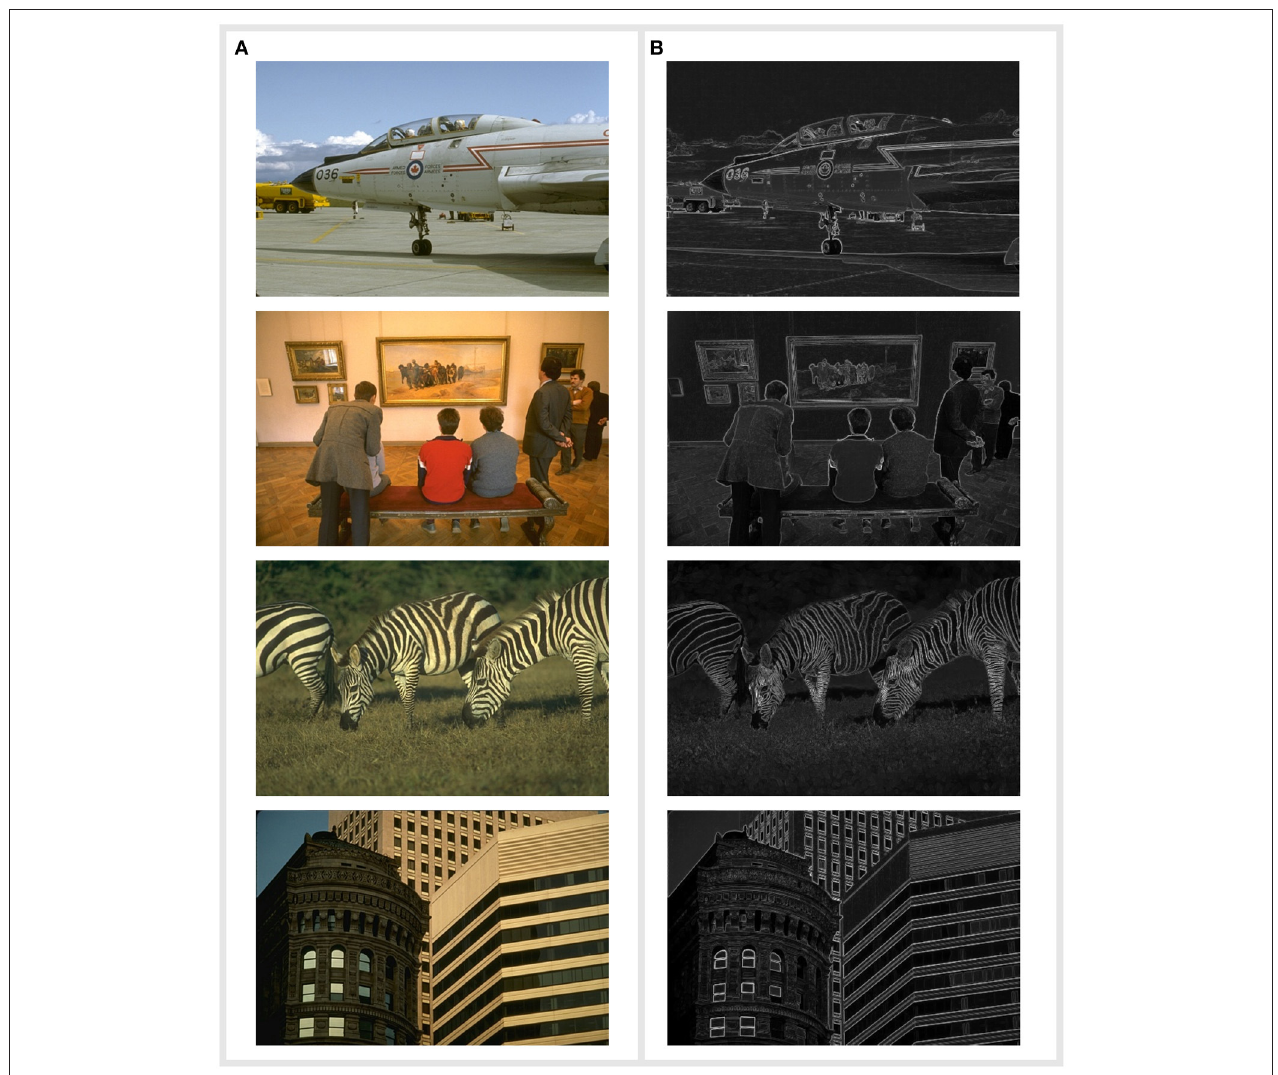
FIGURE 4 | (A) A sample of the original input images presented to the circuit. Source: Arbeláez et al. (2011). In simulation, there exists an edge detection circuit between each neighboring pixel. Pixels are mapped from their 0–255 value to a frequency range between 50–100 Hz. (B) The corresponding output images of the simulation. Each pixel represents the output of an edge detection circuit placed between two neighboring pixels. The average amplitude of output spikes above a threshold is mapped from the voltage to a pixel value from 0 to 255 and is plotted in this image. Brighter pixels indicate edges. We have combined the simulations of edge detection in both the vertical and horizontal